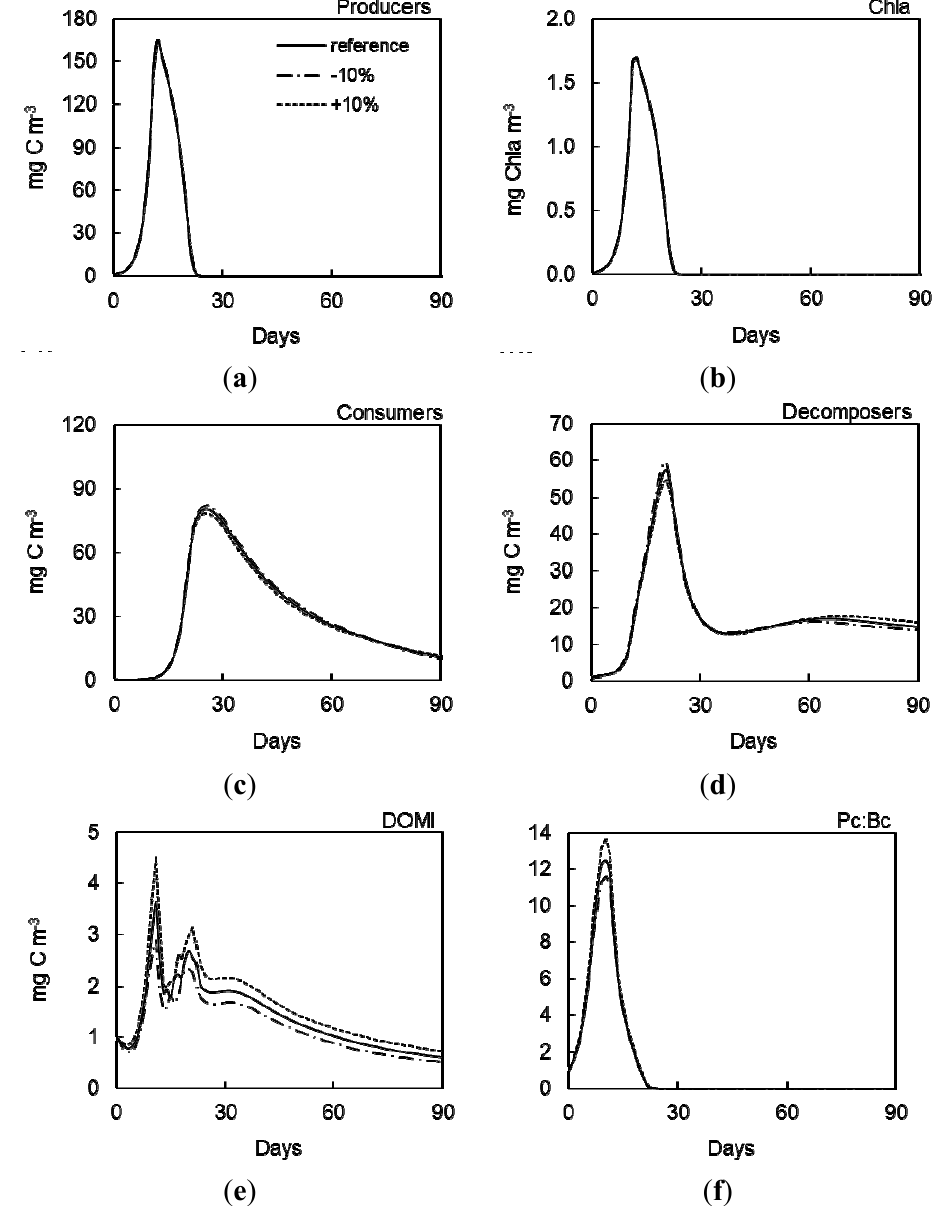
Figure 4. Temporal evolution of the response of ( a ) producers biomass, ( b ) chlorophyll a (Chla), ( c ) consumers biomass, ( d ) decomposers biomass, ( e ) labile dissolved organic carbon, and ( f ) producers:decomposers ratio to the perturbation of ref_temp